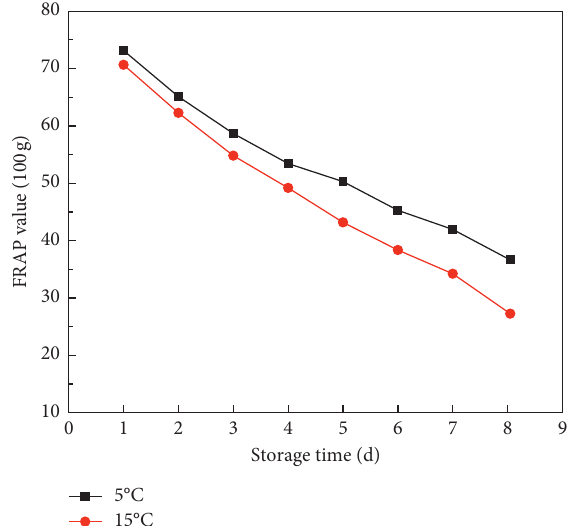
Figure 4: Analysis results of total antioxidant capacity of potato seedlings.